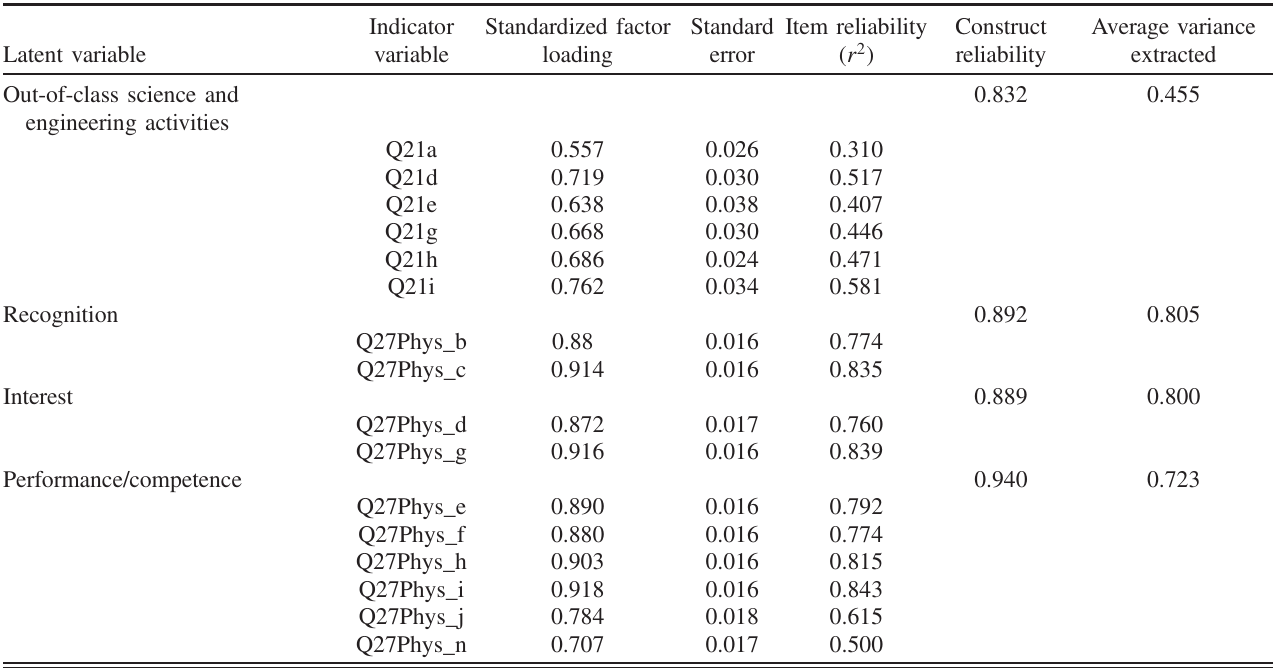
TABLE IV. Confirmatory factor analysis ( N ¼ 5988